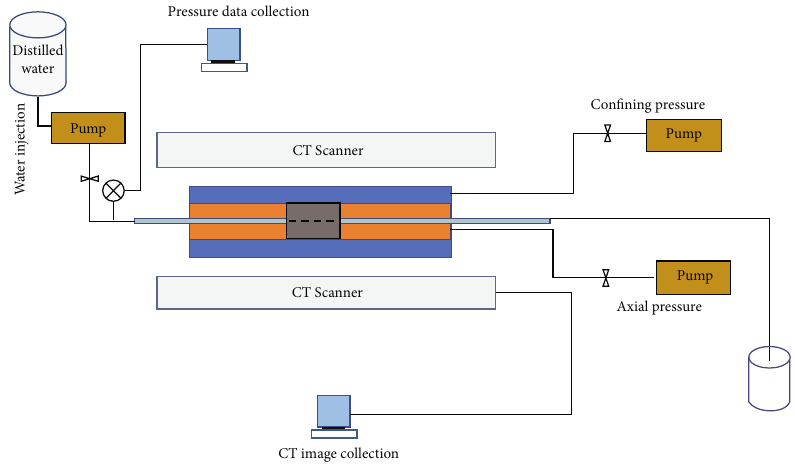
Figure 11: The schematic of the test system (Liu and Sheng [10] and Liu and Sheng